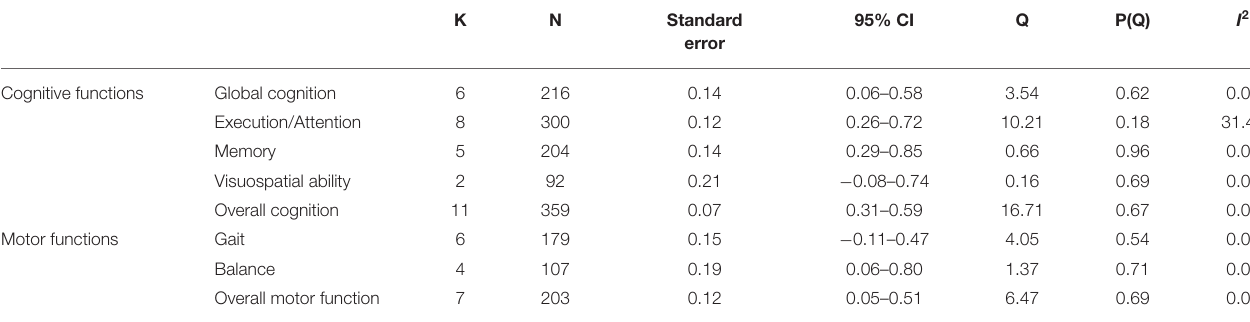
TABLE 4 | Mean weighted effect sizes, confidence interval, and heterogeneity for primary and secondary outcome measures.